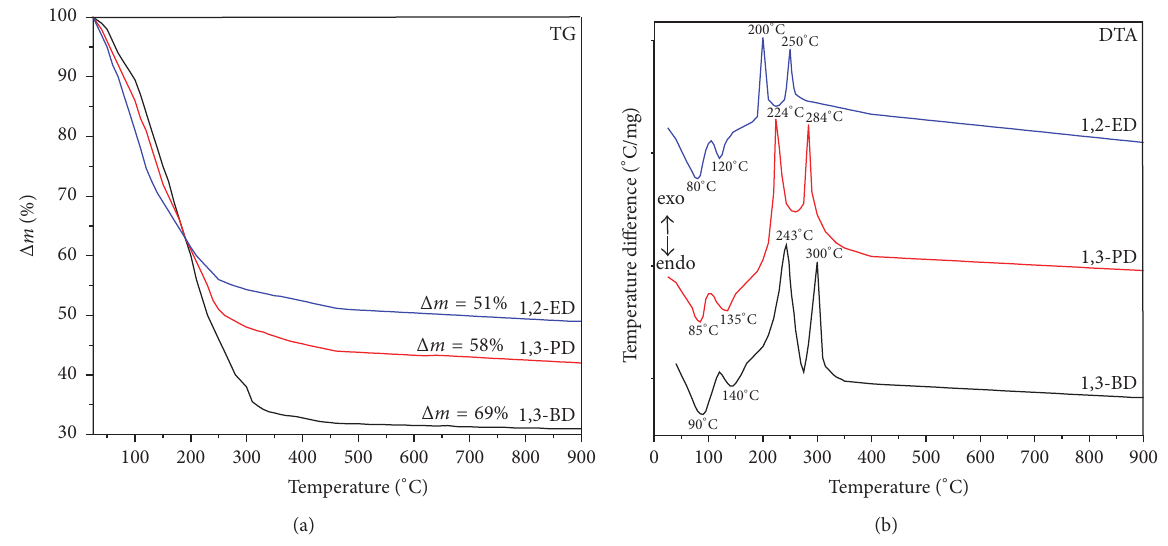
Figure 5: Thermal analysis (TG and DTA) of carboxylate precursors.